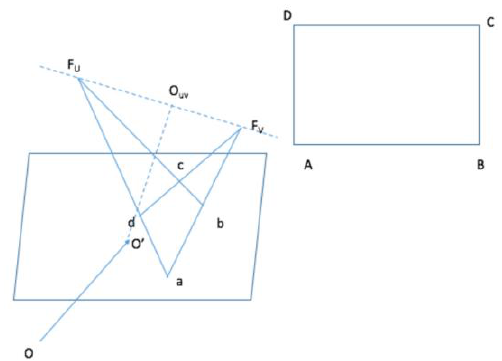
Figure 7. Schematic diagram of vanishing-point imaging.